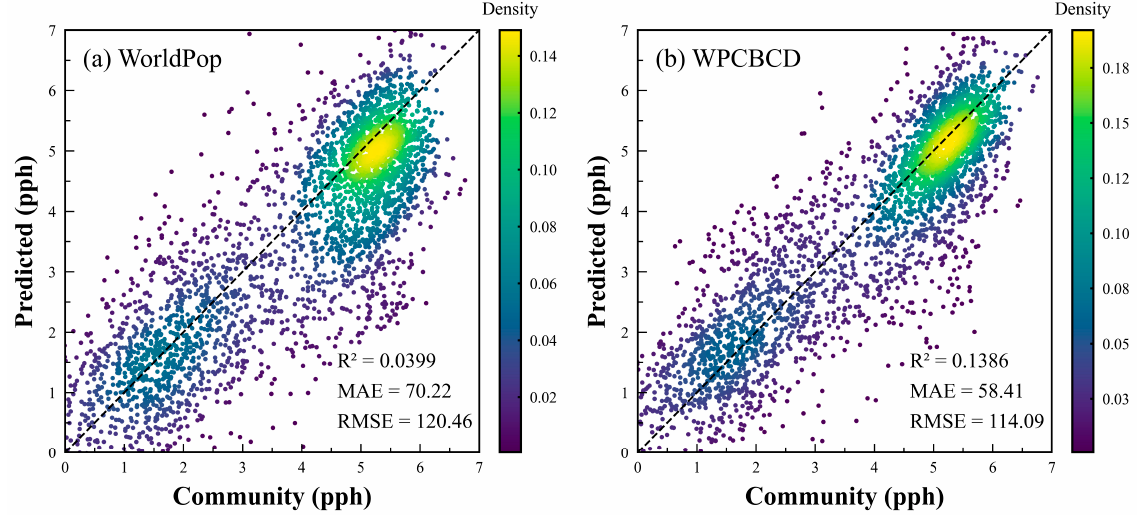
Figure 9. ( a ) Scatter plot of the predicted by WorldPop and the community committee sites population density at the pixel level (Total of 3485 pixels). ( b ) Scatter plot of the predicted by WPCBCD and the community committee sites population density at the pixel level (Total of 3485 pixels). A ln-ln transformation was conducted for the population density. The black dash line indicate 1:1 line. pph: persons per hectare. WPCBCD: WorldPop corrected by census